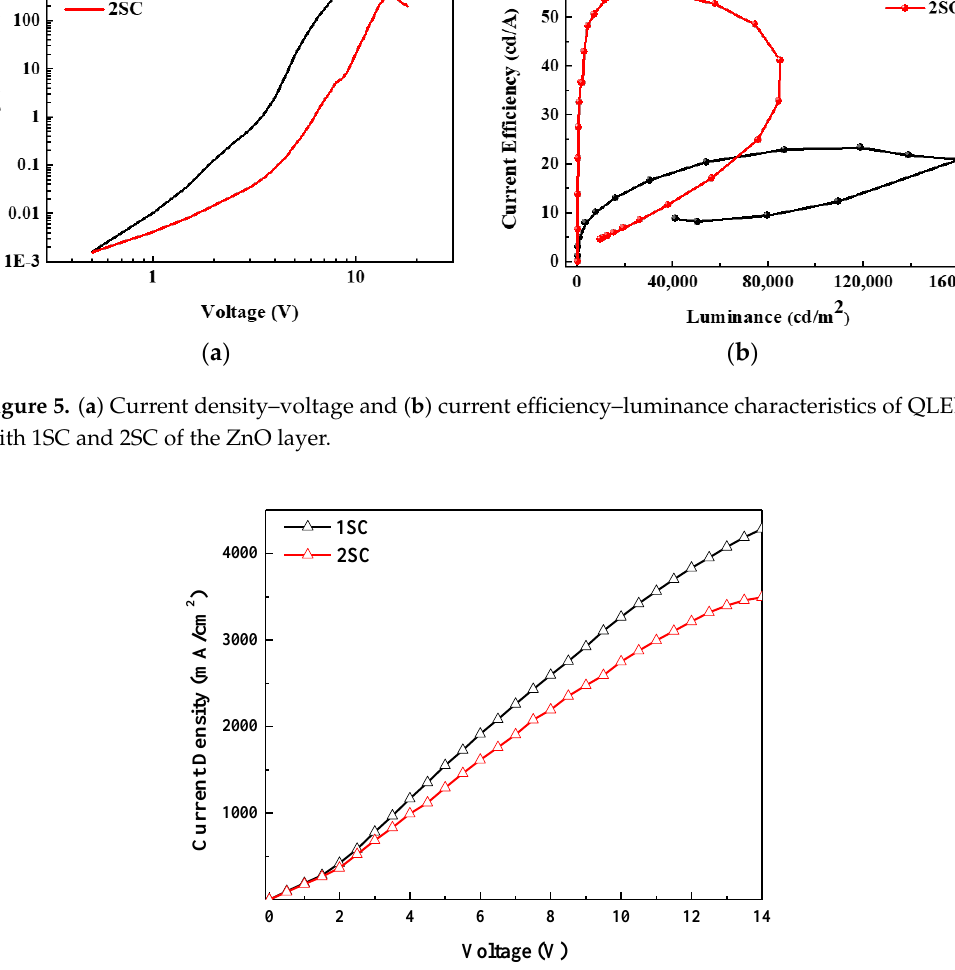
Figure 6. Current density–voltage characteristics of electron-only devices (EODs) with 1SC and 2SC of the ZnO layer.